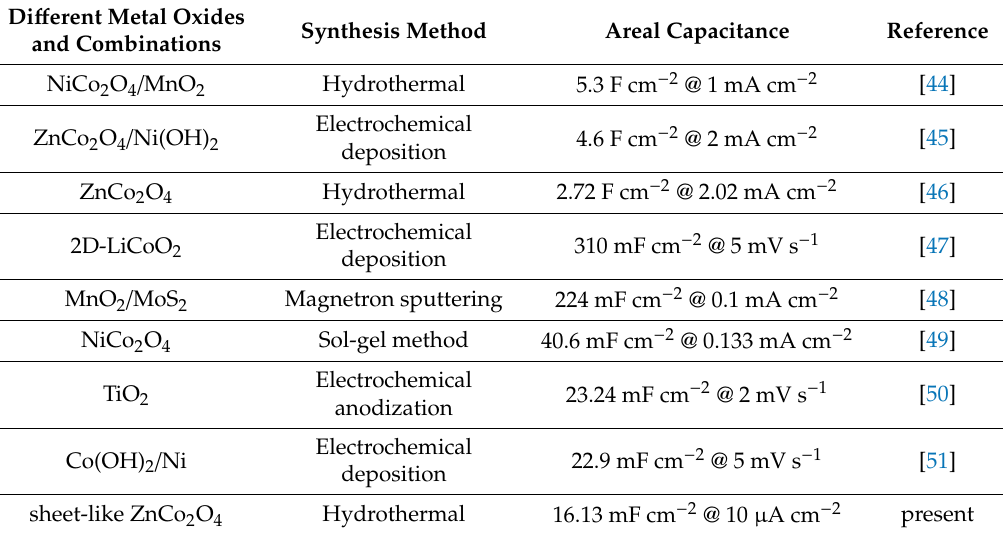
Table 4. Areal capacitance of di ff erent metal oxides in comparison with present